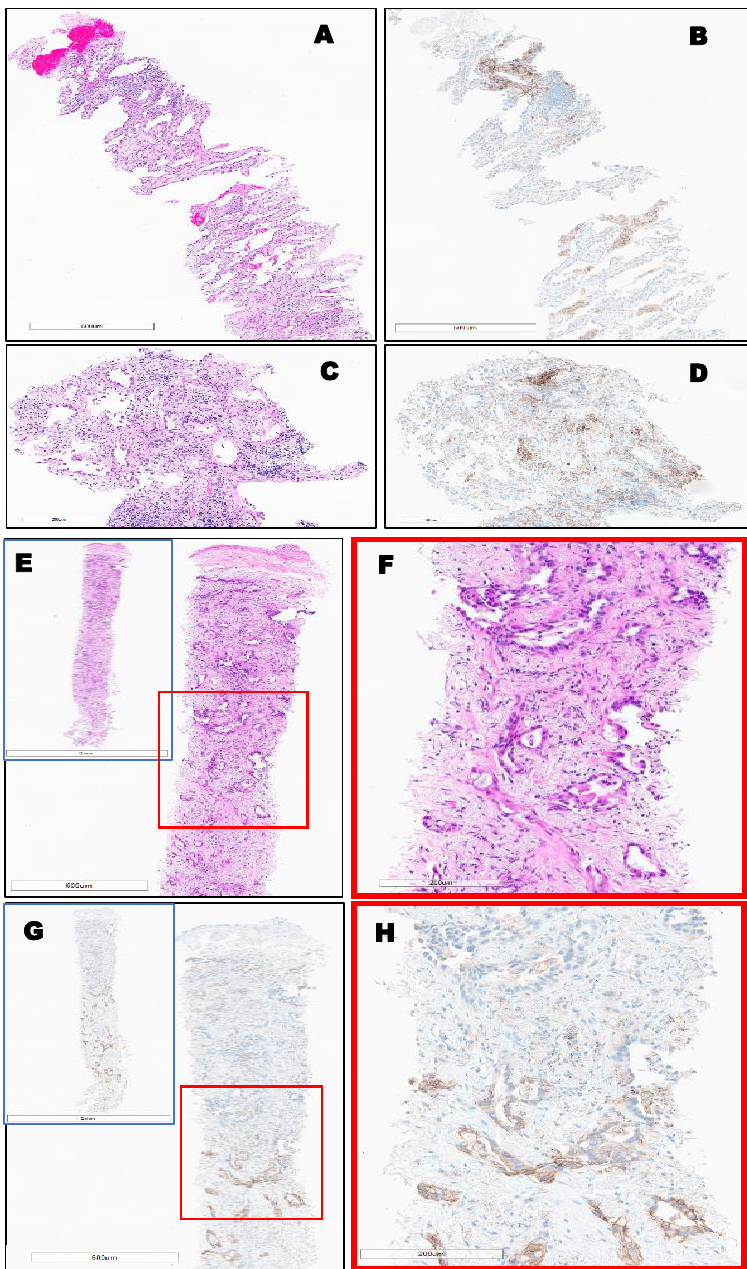
Figure 5. Invasive lung-primary adenocarcinoma, EGFR mutated, (TPS = 5%) Top ( A – D ). Bottom, ( E – H ): Invasive lung-primary adenocarcinoma identified throughout the entire biopsy, (TPS = 50%) using PD-L1 (22C3) FDA (Keytruda ® ), where a strong stain is only observed in the bottom half of the biopsy (G-H) and not adenocarcinoma at the top of the image.